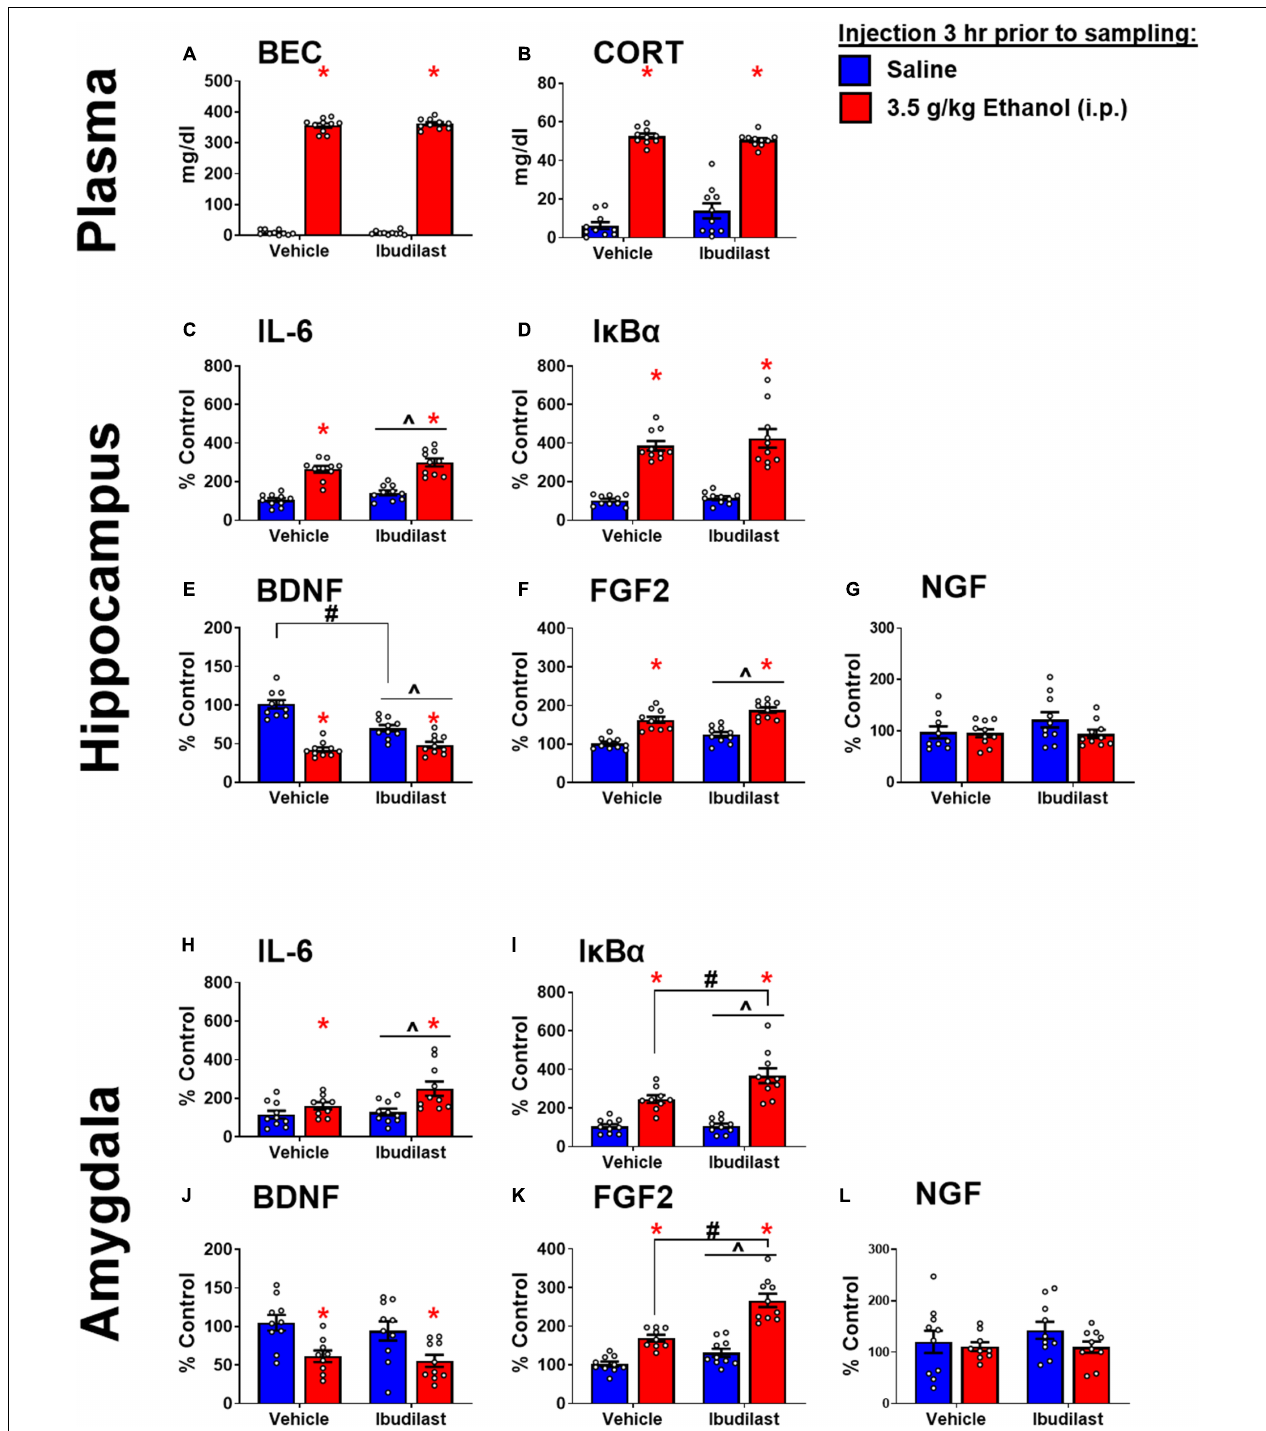
FIGURE 4 | Ethanol-induced gene expression in adult males treated with ibudilast. (A) BECs, (B) CORT levels in plasma, gene expression of IL-6 (C,H) , I κ B α (D,I) , BDNF (E,J) , FGF2 (F,K) , and NGF (G,L) in the dorsal hippocampus and amygdala were assessed in rats pretreated with ibudilast or vehicle before i.p. injection of saline or 3.5 g/kg ethanol. Gene expression data were calculated as a relative change in gene expression using the 2- (cid:49)(cid:49) C(t) method, with (GAPDH) used as a reference gene and the vehicle – saline group serving as the ultimate control for each sex individually. Bars denote group means ± standard error of the mean (represented by vertical error bars). There is a main effect of ethanol in every measure. Chevron ( ∧ ) indicates main effect of ibudilast, asterisk (*) indicate significant interaction of ethanol and ibudilast with significant posthoc comparison (Tukey’s).